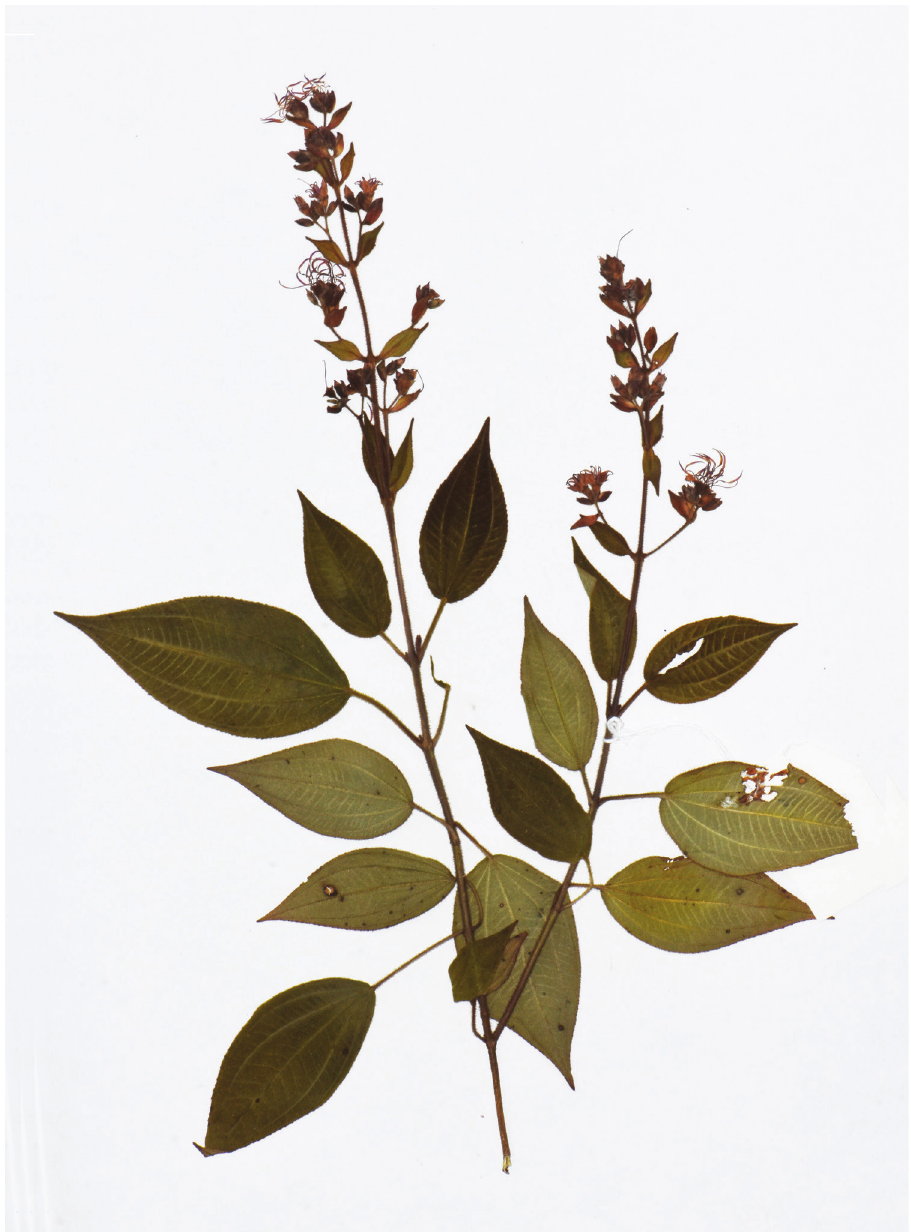
Figure 11. Y. Liu 568 (A) collected from Lingxia, Pingnan County, Fujian, China, holotype of Tashi- roea villosa